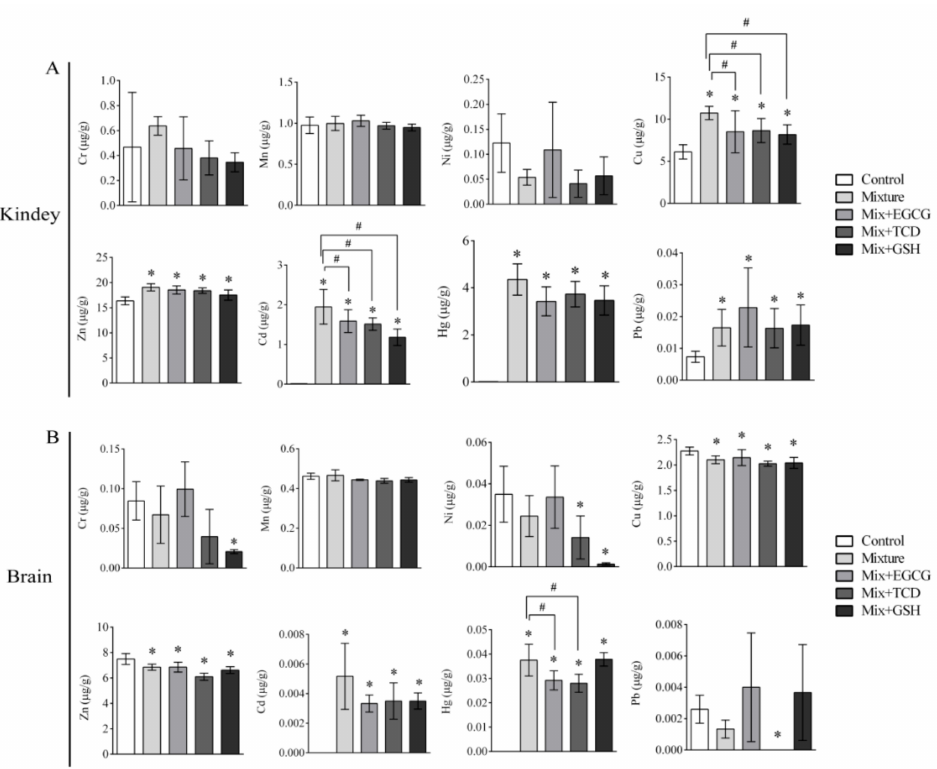
Figure 5. Contents of eight heavy metals in the kidney and brain of SD rats. Bars represented contents of eight heavy metals (ug) in per gram of organs; ( A ) Contents of eight heavy metals in the kidney of SD rats; ( B ) Contents of eight heavy metals in the brain of SD rats; n = 6 rats / each group; Results were presented as means ± SD; One-way ANOVA and LSD-t test were used. * p < 0.05, vs. the control group (Mixture, Mix + EGCG, Mix + TCD, Mix + GSH compared with the control group); # p < 0.05, vs. the Mixture group (Mix + EGCG, Mix + TCD, Mix + GSH compared with the Mixture group); Mix, Mixture.